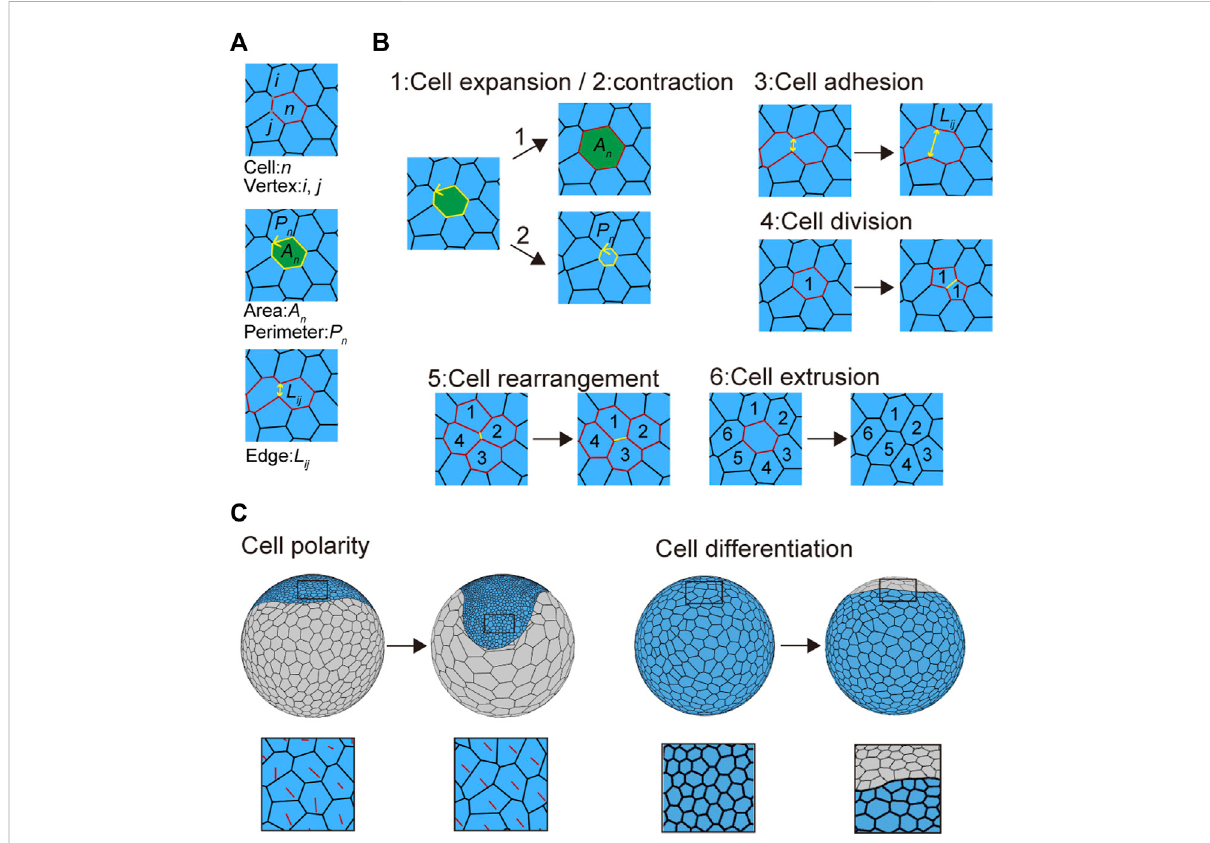
FIGURE 2 Mechanical cell properties in embryos. (A) Virtual cells in the vertex model. The letters n , ( i , j ), A n , P n , and L ij in the panels represent the cell number, vertex number, cell area, cell perimeter, and cell edge length, respectively. (B) Cell behaviors introduced into the cell vertex model. Three cell mechanics are modeled:1)cell expansion, 2)cell contraction,and 3) cell adhesion.1) Cell expansion and 2) cell contraction mainlycontributeto increasing or decreasing cell area ( A n ) and perimeter ( P n ), whereas 3) cell adhesion mainly contributes to increasing or decreasing cell edge length ( L ij ; see in Eq. 3 in Methods). Three types of context-dependent cellular events are modeled: 4) cell division, 5) cell rearrangement, and 6) cell extrusion. Numbersin thepanels indicate cell positional relationships. Black arrows indicate time advanced.SeeSupplementary Movie S3 for details. (C) Cell polarity (left) and cell differentiation (right) associated with cell shaping. Red lines indicate cell polarity direction (left bottom), while blue and gray cells indicate embryonic and abembryonic cell populations, respectively